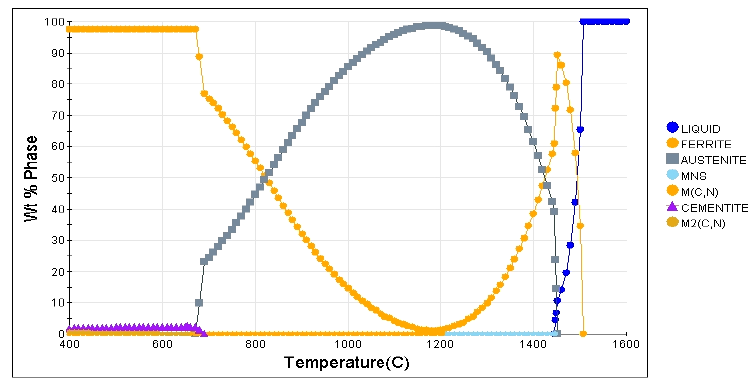
Figure 3. Equilibrium evolution of phases in 3 Mn steel calculated using the JMatPro package.